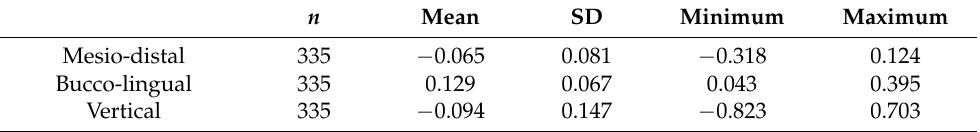
Table 1. Descriptive statistics of the linear deviation measurements (mm) of the STL digital files. n Mean SD Minimum Maximum Mesio-distal